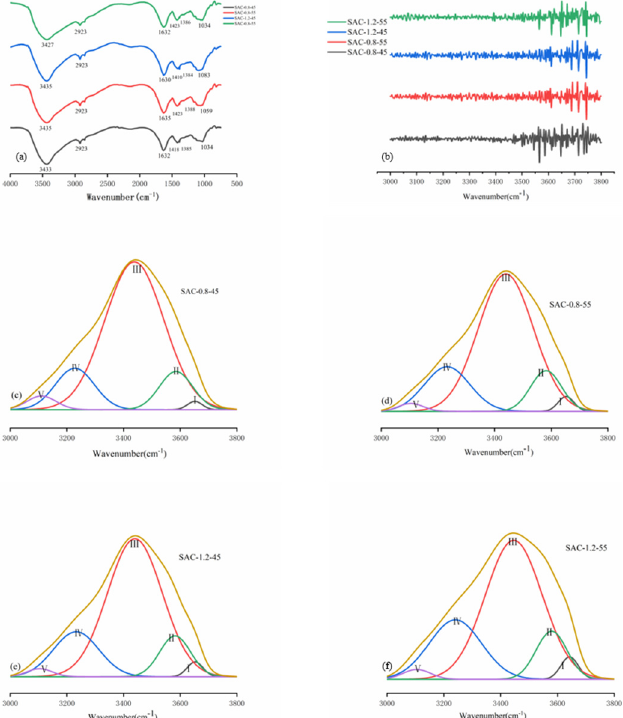
Figure 3. ( a ) The infrared spectrum of SA/AKP/CNCs composite fiber, ( b ) the second derivative spectrum of SA/AKP/CNCs composite fiber, Gauss curve fitting of SA/AKP/CNCs composite fiber by different types of hydrogen bonds ( c ) SAC-0.8-45, ( d ) SAC-0.8-55, ( e ) SAC-1.2-45, ( f ) SAC-1.2-55. By comparing SAC-0.8-45 and SAC-1.2-45, SAC-0.8-55 and SAC-1.2-55, we found